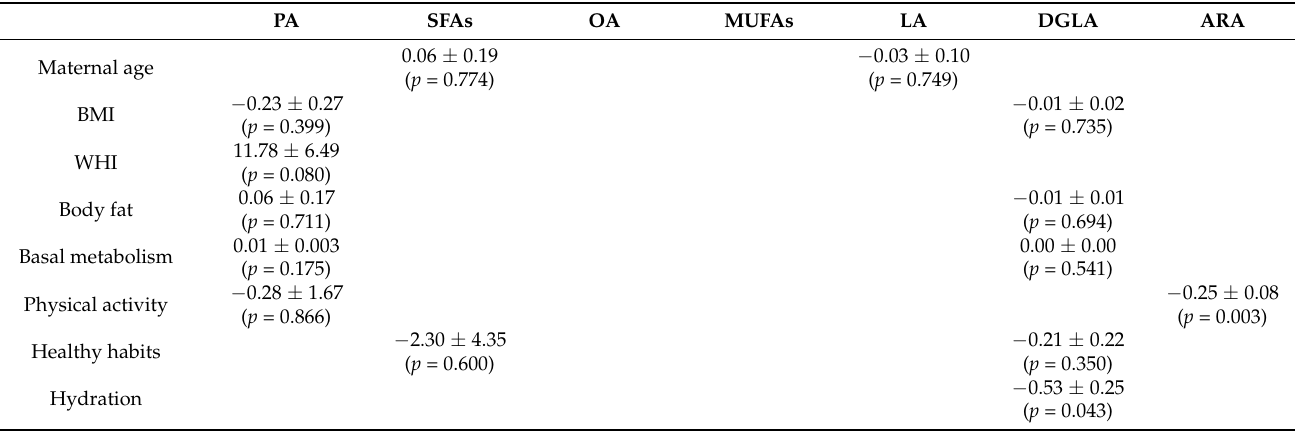
Table 2. Association between breast milk palmitic, oleic, SFAs, MUFAS, and omega-6 fatty acids with maternal body composition and nutritional